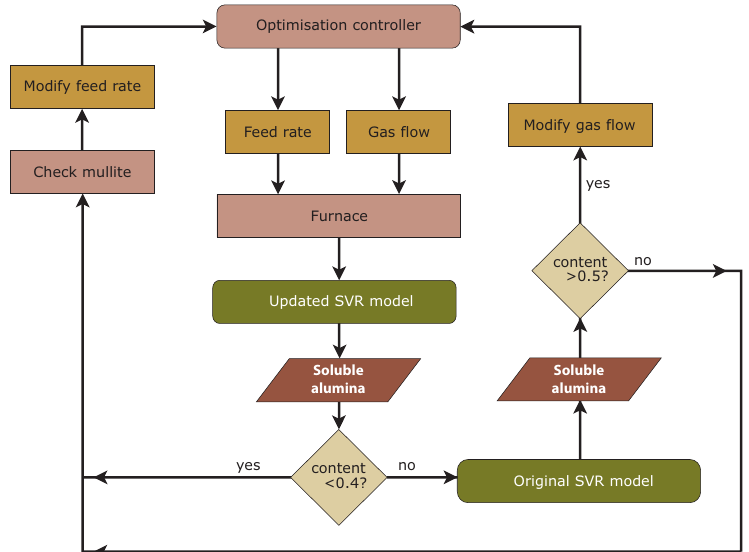
Figure 5. Proposed monitoring scheme for the quality control of the production of calcined kaolin based on the IR estimation of soluble alumina to be integrated into the enhanced control strategy proposed by Jämsä-Jounela et al.